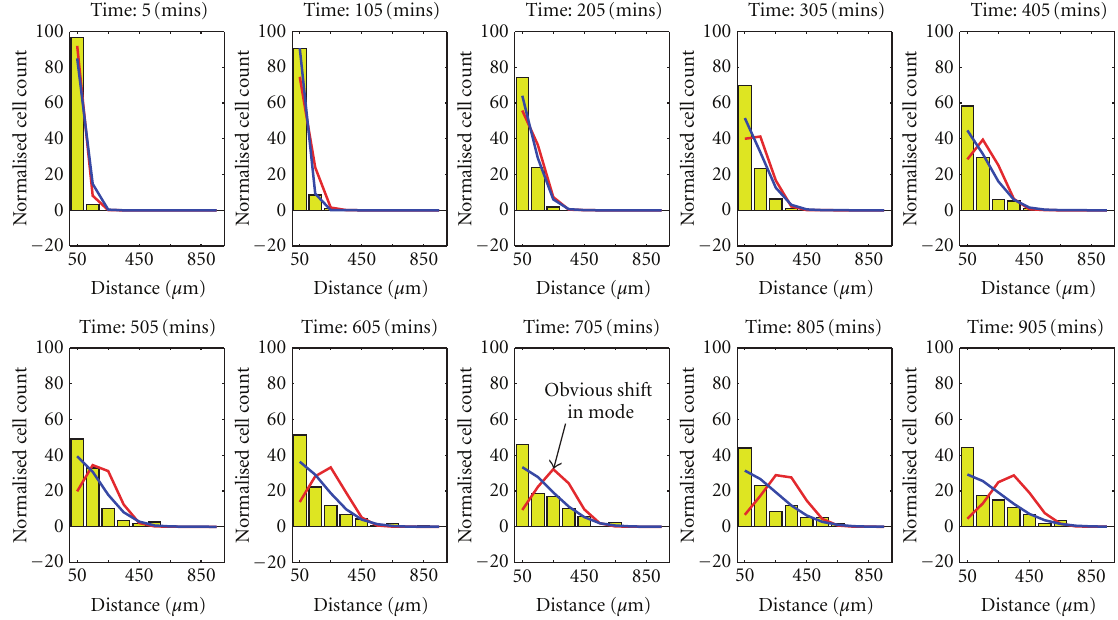
Figure 5: Simulation reveals a pure-di ff usion model to be a better fit to the real data. Both the drift-di ff usion model (red line) corresponding to drift (0.26 μ m/min) and di ff usion (8.0 μ m/min) and the pure-di ff usion model (blue line) corresponding to di ff usion (41.8 μ m/min) were simulated 1000 times. The simulations were used to produce a distribution for the spatially binned data of each model. The mean values of cell distribution over space are shown by the red and blue lines, respectively (in terms of distance from the wound). Overlaid on these is a corresponding histogram representation (yellow) of the real data (combined over all fish). The histogram bins have width 100 μ m and are centered at 50 μ m to 950 μ m from the wound. The pure-di ff usion model shows a correct qualitative prediction of cell distribution whereas the drift-di ff usion model predicts that the population mode moves away from the wound over time, in contrast to the observed data.